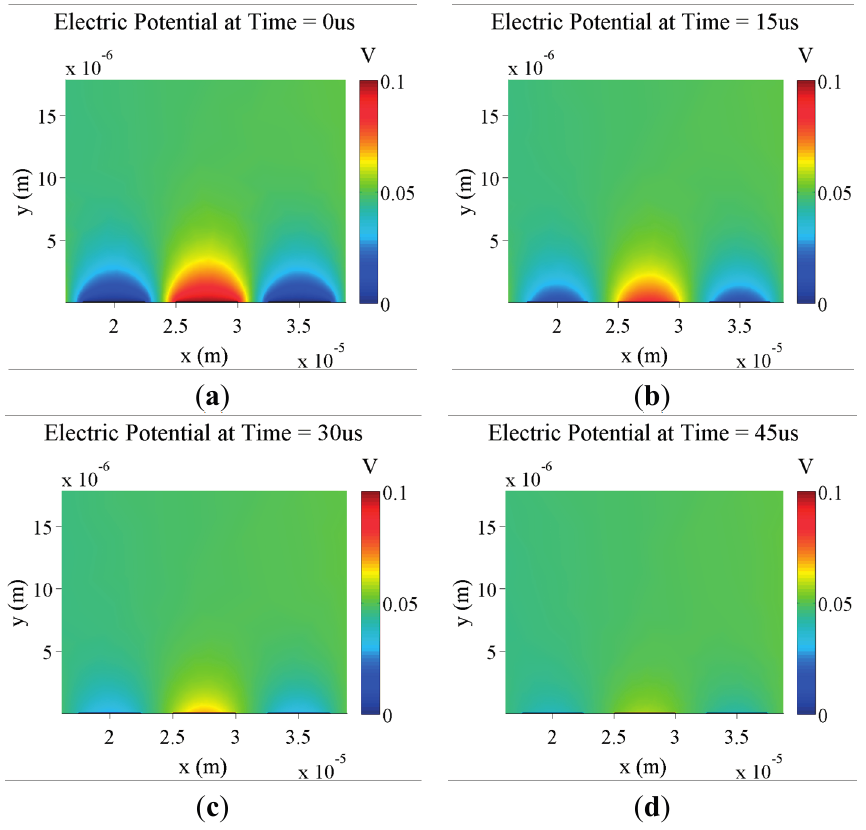
Figure 3. Simulation of the formation of electrical screening layers over time. Plots show the electric potential of IDEs (5 µm digit width and 2.5 µm spacing) with 0.1 V DC applied with a background KCl concentration of 150 µM. Plots are taken at five different time